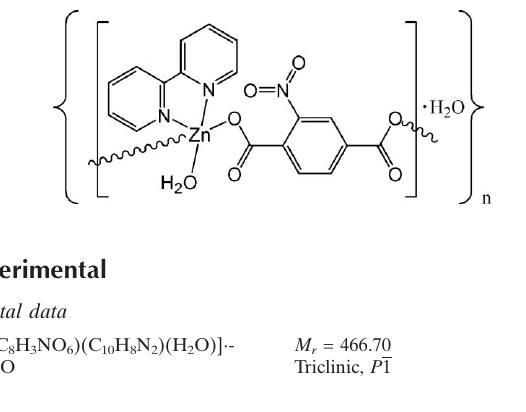
Data collection: SMART (Bruker, 2002); cell refinement: